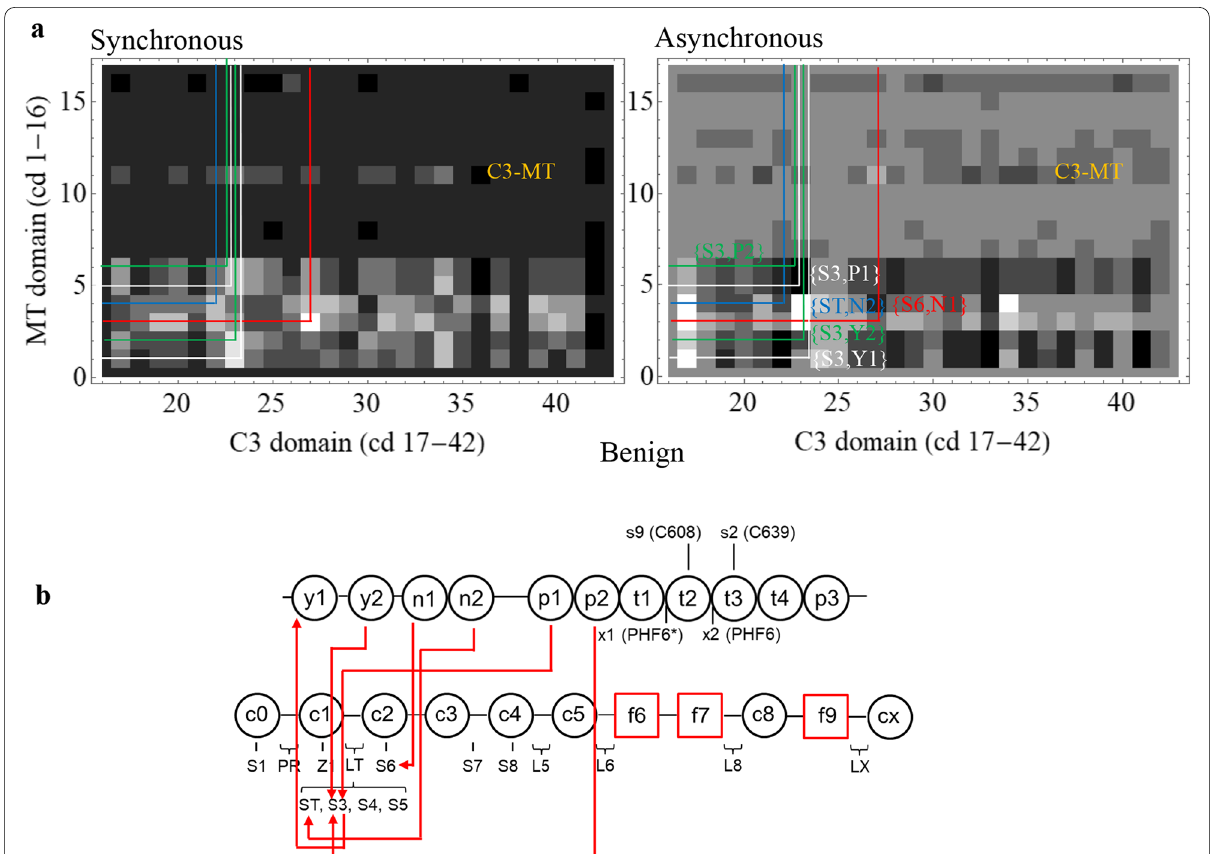
Fig. 8. MAPT/MYBPC2 complex cross-correlation maps and their implied inter-protein domain linkages for benign outcomes. a C3-MT region for synchronous and asynchronous maps and the portion of the correlation squares falling within them for benign outcomes taken from Supplementary Figure S6. b Red lines show most significant directed co-domain interactions between MAPT and MYBPC3 for benign outcomes. Nomenclature is otherwise identical to Figs. 4 and